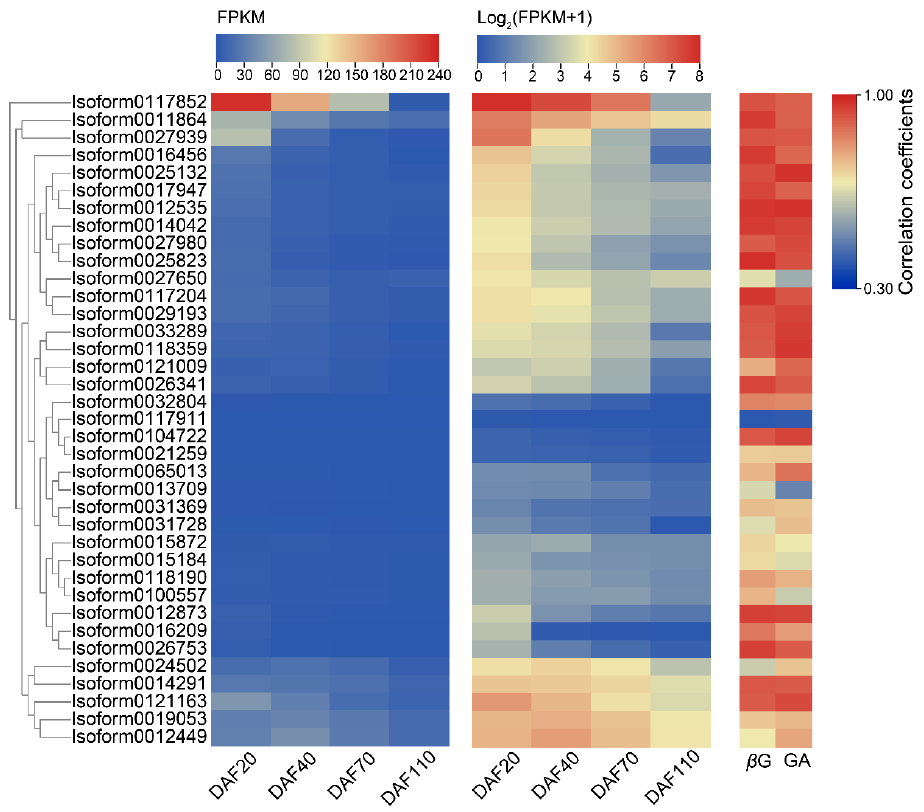
Figure 4. The expression patterns of CaUGTs in four developmental stages of C. album fruits and the correlation coefficients between CaUGT expression levels and GA and β G contents. FPKM values of four developmental stages days (20 days after flowering (DAF), 40 DAF, 70 DAF, and 110 DAF) of C. album fruit were obtained from RNA-seq data of our lab .